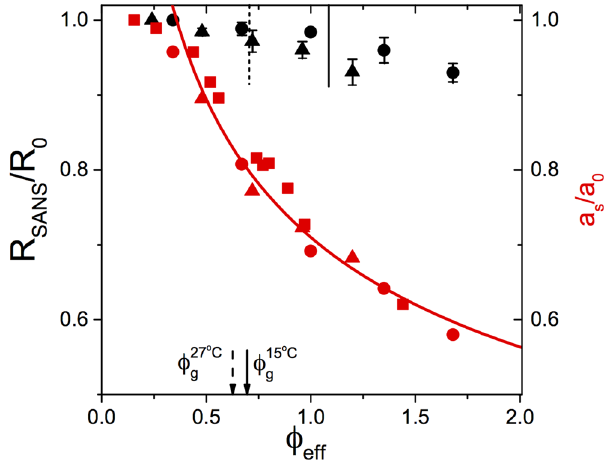
Figure 3. Summary of the results obtained by SANS and SAXS. Shown are: Normalised overall dimensions R SANS / R SANS ,0 as a function of φ eff obtained from SANS measurements using ZAC conditions at T = 15 °C (ILL) and 16.4 °C (PSI), respectively, where R SANS ,0 corresponds to the value at φ eff → 0 (solid black circles). The values correspond to the average obtained in different independent measurement campaigns at two different neutron sources, and the error bars reflect the standard deviations of these experiments. Also shown are the overall dimensions R SANS / R SANS ,0 as a function of φ eff at T = 27.1 °C (ILL) and 27.4 °C (PSI) (solid black triangles). The average normalised center-center distances a s / a 0 from SAXS are shown as the red solid circles for T = 15 °C and triangles for T = 27 °C, where a 0 = 2 R h [ T ] × R SANS / R SANS ,0 . The average normalised center-center distances a s / a 0 from CLSM are shown as the red solid squares for T = 15 °C. The red solid line represents the dependence of the normalised center-center distance on the number density for particles interacting via a soft repulsive potential 1/3 expected for φ ≥ φ φ given by φ − ~ a a / eff rcp , where rcp corresponds to random close packing. The location of s eff 0 the glass transition is indicated by the black solid arrow ( T = 15 °C) and the black dashed arrow ( T = 27 °C) at the bottom, and an estimate of the volume fraction φ eff where the outer shell touches the dense core of the nearest neighbour particles is given as the short solid black ( T = 15 °C) and dashed ( T = 27 °C) lines at the